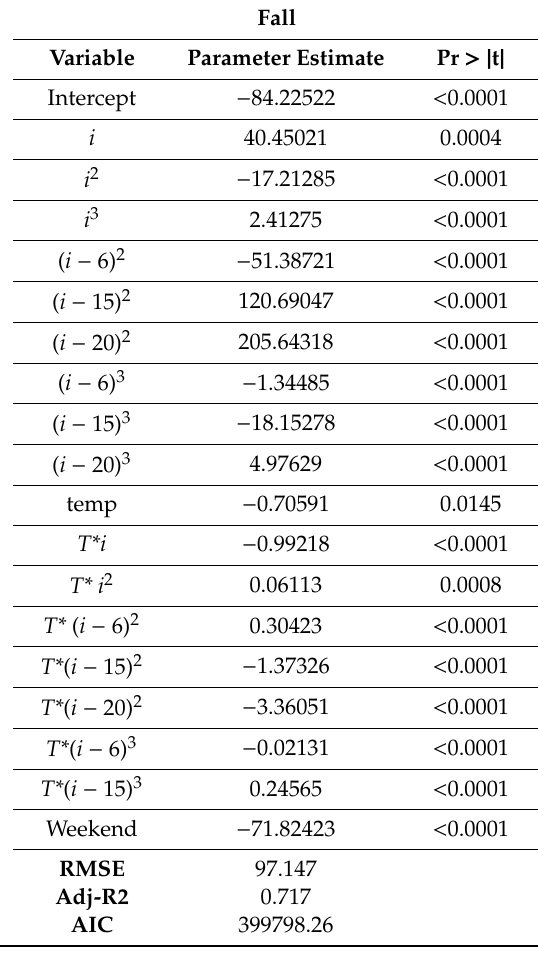
Table A7. The Results for the Regression Model for the Summer and Fall Seasons (Model